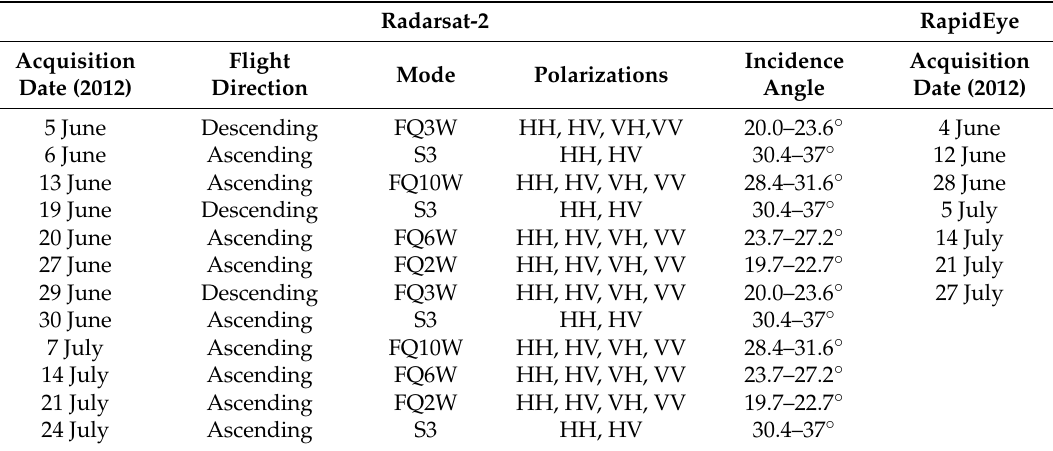
Table 1. The satellite images used in this